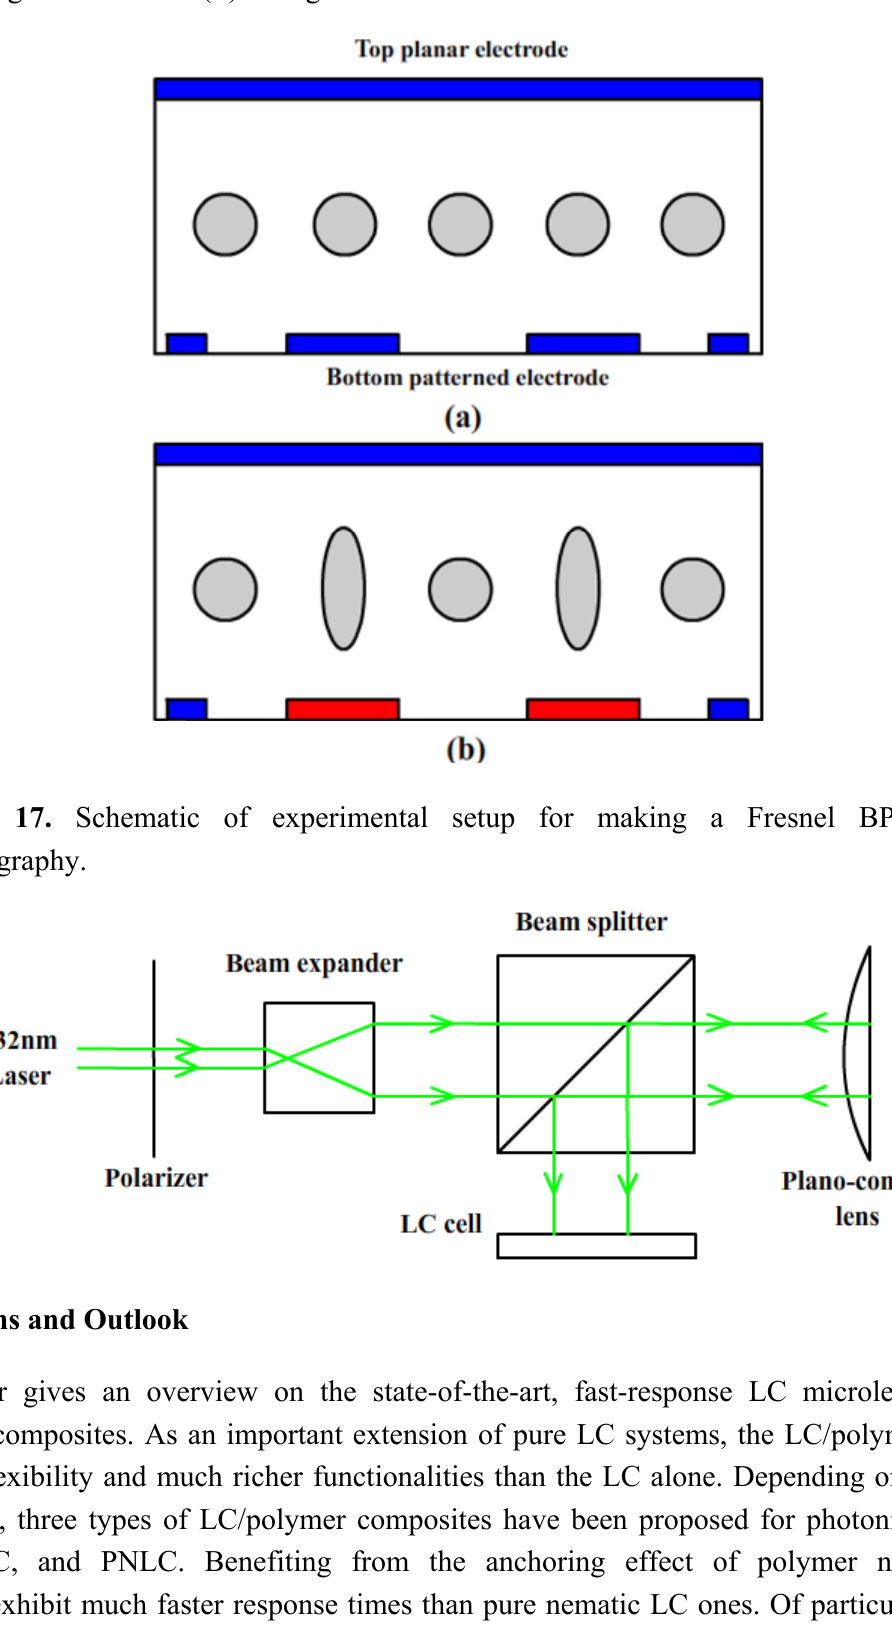
Figure 16. The device configuration and working principle of a Fresnel BPLC lens: